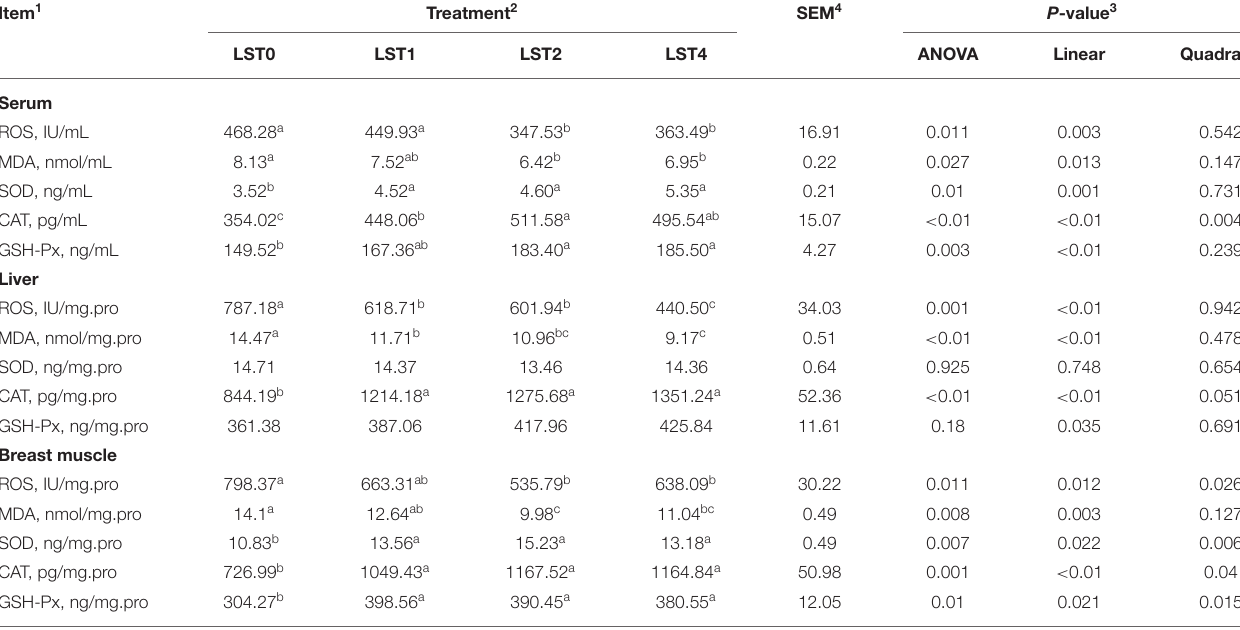
TABLE 5 | Effect of dietary LST powder supplementation on serum, liver, and muscle antioxidant status of broiler chickens ( n = 6). Item 1 Treatment 2 SEM 4 P -value 3 LST0 LST1 LST2 LST4 ANOVA Linear Quadratic Serum